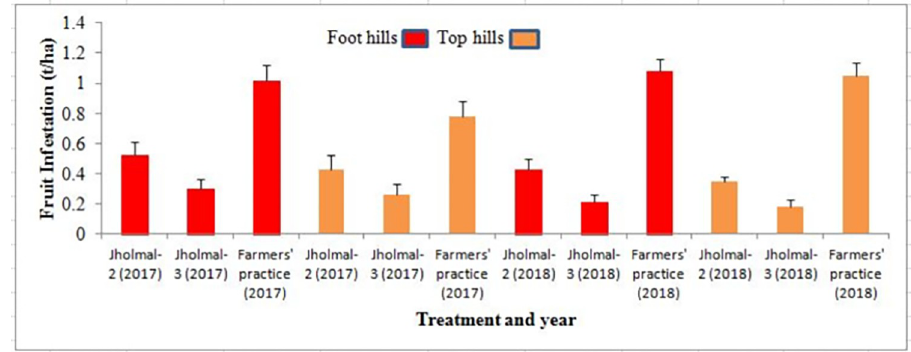
Fig 5. Fruit fly infestation under different treatments in two agro ecological